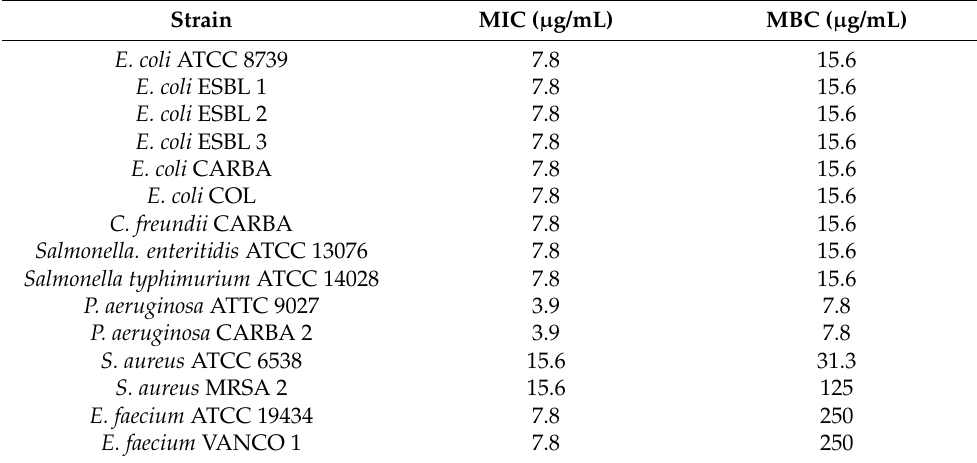
Table 2. MIC and MBC values ( µ g/mL silver) for the C3-L1 product against various strains. Identical results were obtained in the three replicates.